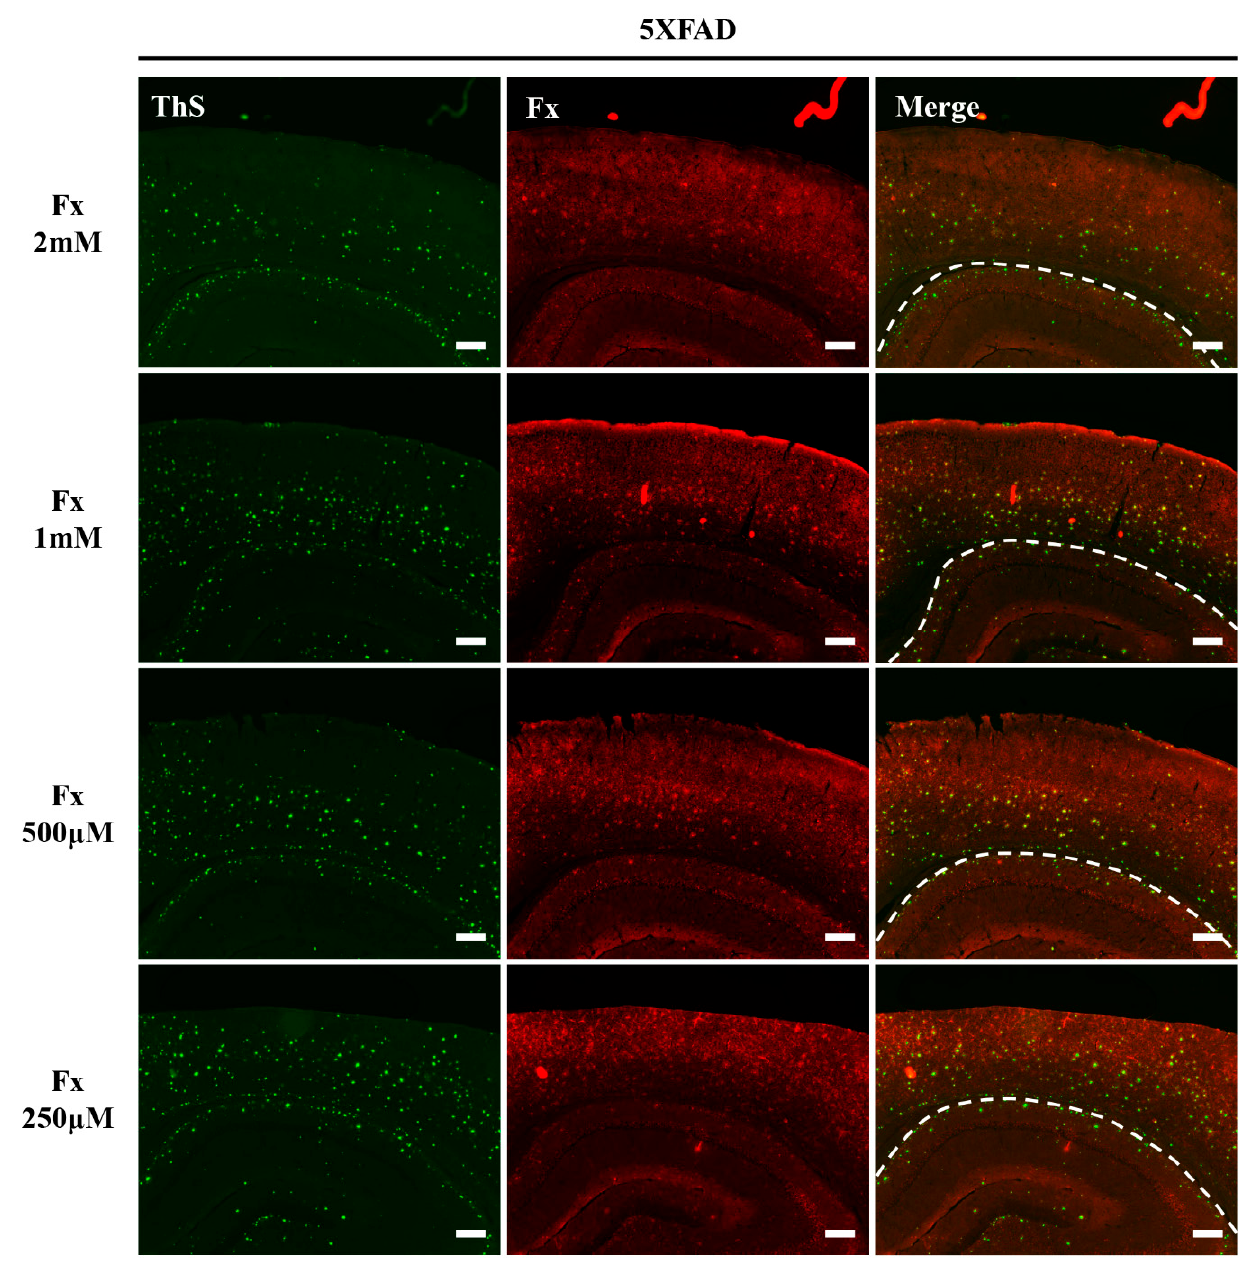
Figure 4. Fucoxanthin staining using the water-based washing method detected ThS-positive A β plaques in 5 × FAD brain tissue. The brains of 10–15-month-old 5 × FAD mice ( n = 4) were visualized for A β plaques with fucoxanthin (Fx) and ThS. The images of ThS and Fx are merged to confirm that they are colocalized. Scale bars = 200 μ m. The region of brain was separated with the white dash line on the images; upper region of dash line, cortex; under region of dash line, hippocampus.